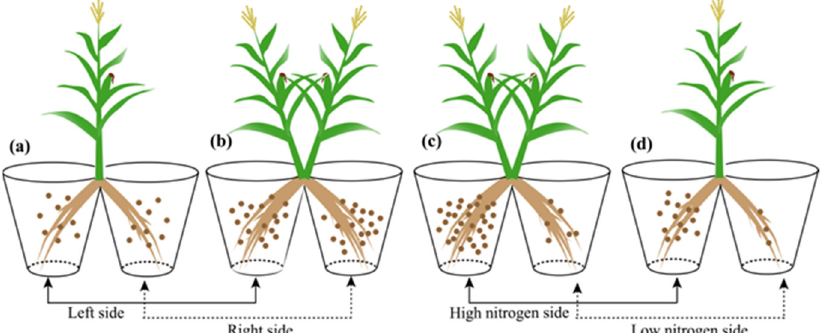
Table 1. Nitrogen application amounts of the different treatments (g/pot).